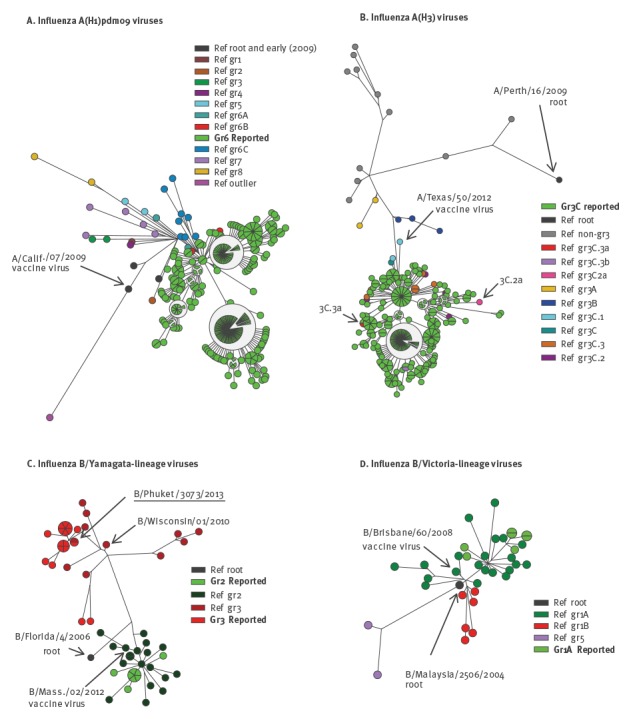
Phylogenetic and cluster analysis of available haemagglutinin 1 sequences, strain-based reporting of antigenic and genetic characterisation data for influenza viruses, 11 European countries, influenza season 2013/14 (n=596)